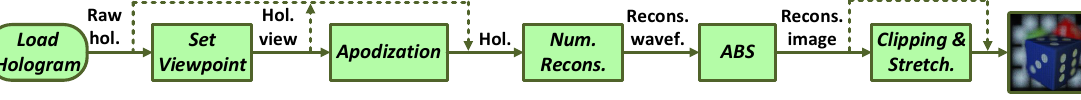
Figure 1. Rendering